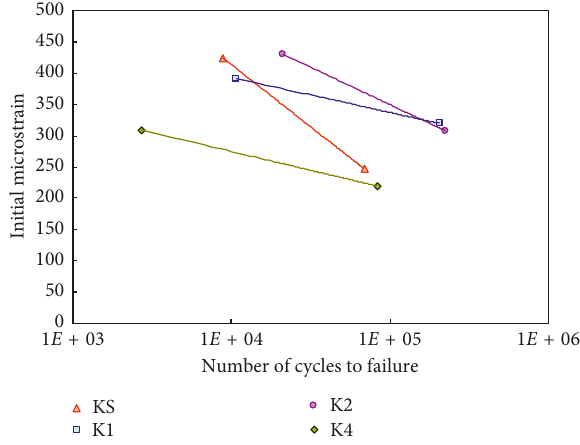
Figure 7: Initial microstrain versus number of cycles to failure for all four mixtures.